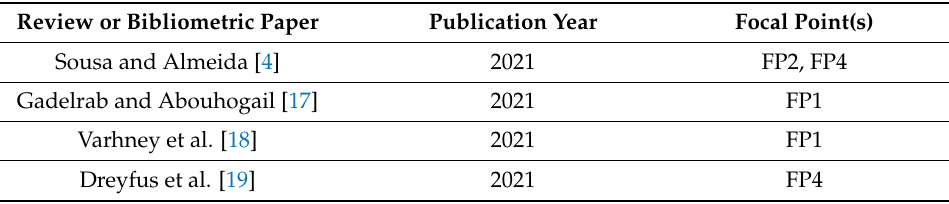
Table 1. Reviews and bibliometric papers on the interplay between smart manufacturing and digital